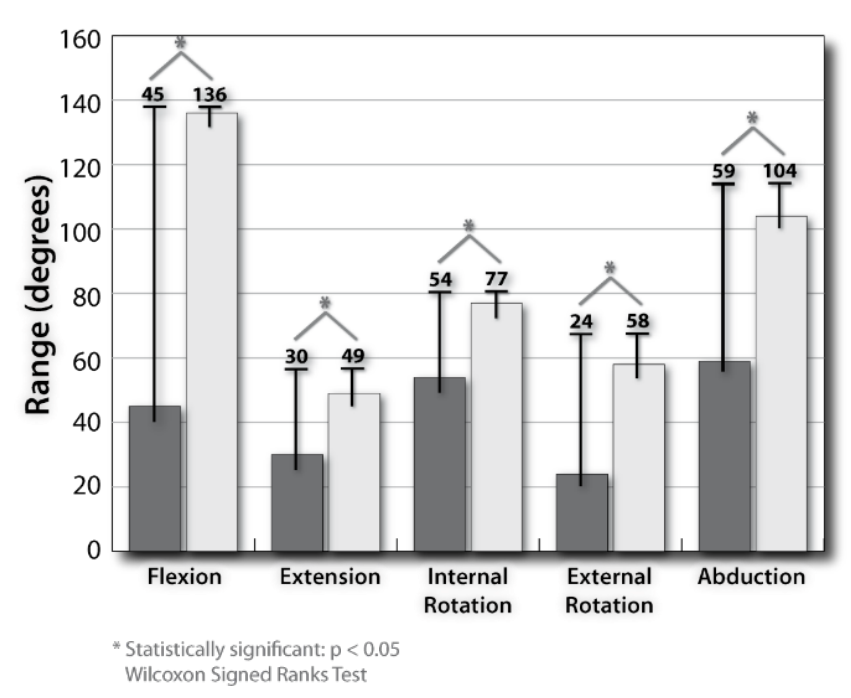
Figure 1. Shoulder range of motion